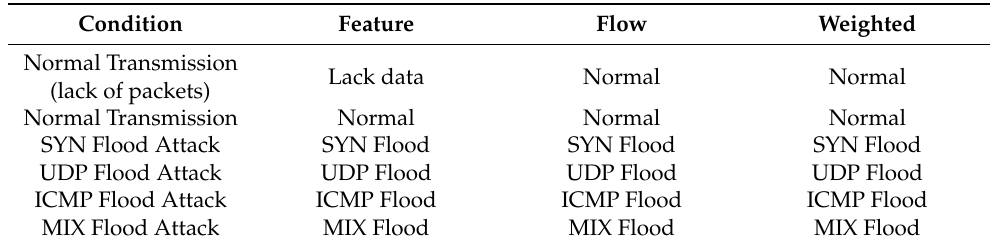
Table 8. Time interval identification under the normal transmission, SYN flood Attack, UDP flood Attack, ICMP flood Attack, and MIX flood Attack. Condition Feature Flow Weighted Normal Transmission Lack data Normal Normal (lack of packets) Normal Transmission Normal Normal Normal SYN Flood Attack SYN Flood SYN Flood SYN Flood UDP Flood Attack UDP Flood UDP Flood UDP Flood ICMP Flood Attack ICMP Flood ICMP Flood ICMP Flood MIX Flood Attack MIX Flood MIX Flood MIX Flood